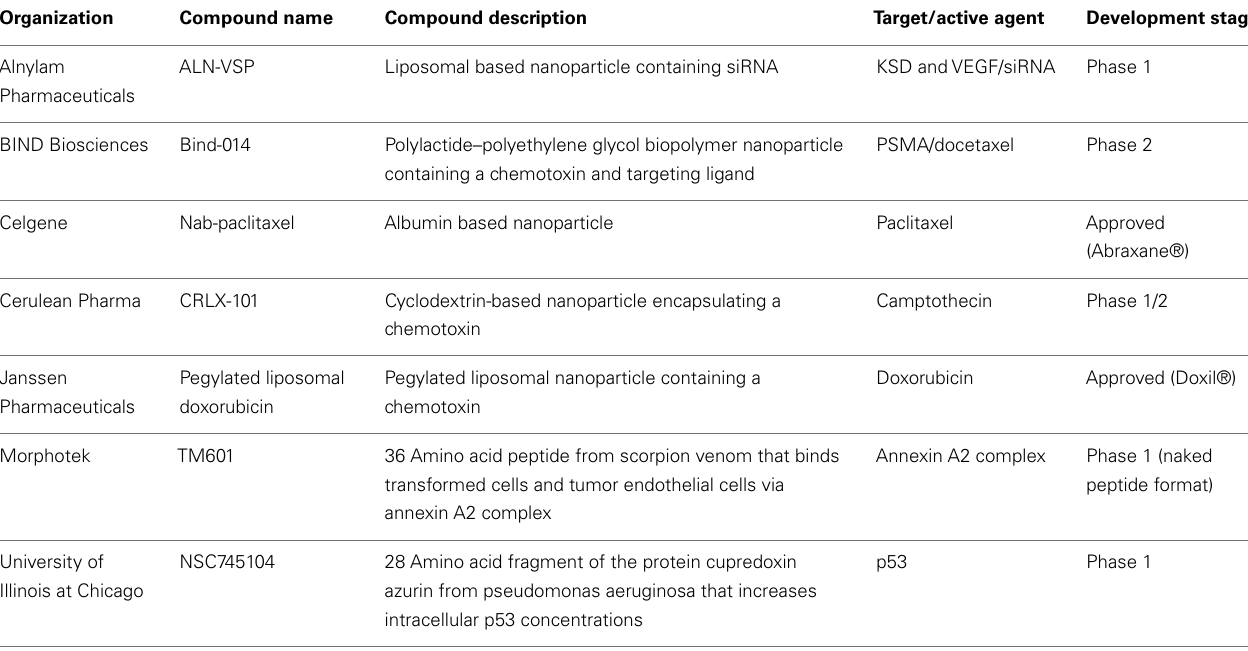
Table 5 | Examples of clinical stage nanoparticles and naturally occurring proteins in development for oncology